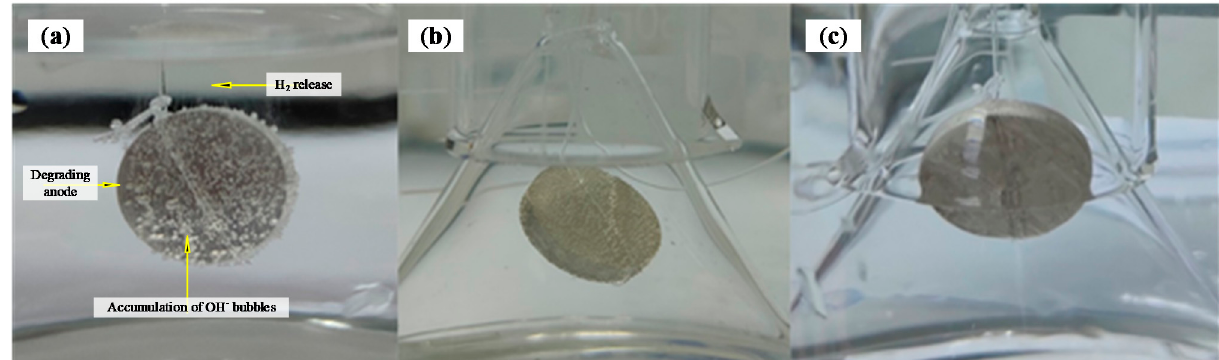
10 of 23 Figure 5. XRD peaks of CP Mg and Mg-1.0Ca-0.5Sr alloy after 14-day immersion in r-SBF corrosion media under different pH control conditions. However, multiple blisters or volcano-like craters appeared in the Tris-HCL buffered r-SBF solution (Figure 4c). At point F, redeposition of corrosion deposits was observed, and this deposit was identified as calcium phosphate (CaP) with a Ca:P ratio of 1.312. However, the dome and the thick flat deposits have since been identified as Mg(OH) 2 based on their analyzed atomic percentage in the EDS analysis at point E.